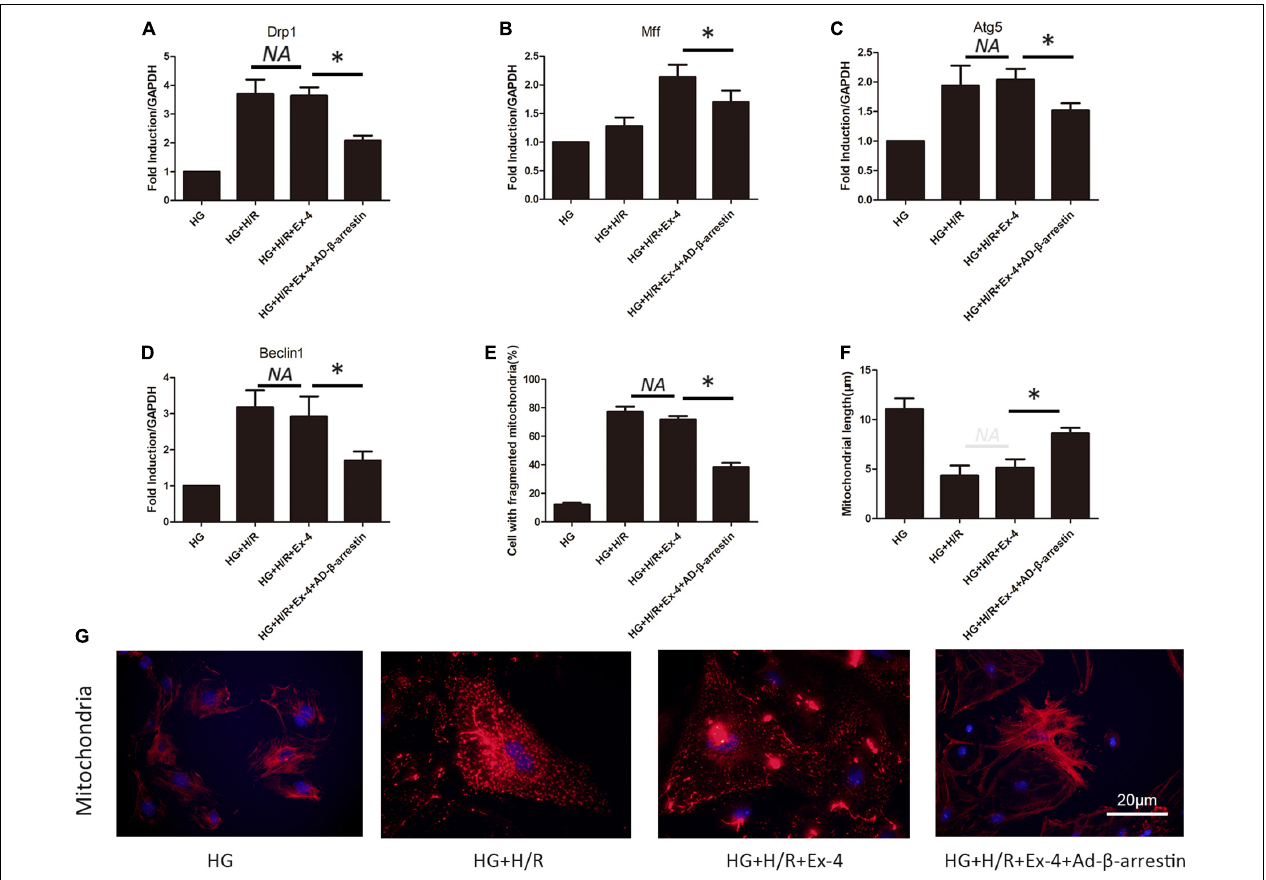
FIGURE 4 | High glucose attenuates cardioprotective effects of GLP-1 through induction of mitochondrial dysfunction via inhibition of β -arrestin-signaling. (A,B) Mitochondrial fission level measured by qRT-PCR analysis of Drp1 and Mff. (C,D) Mitophagy level measured by qRT-PCR analysis of Atg5 and Beclin1. (E–G) Detection of mitochondria morphology using mitochondria staining. *P <